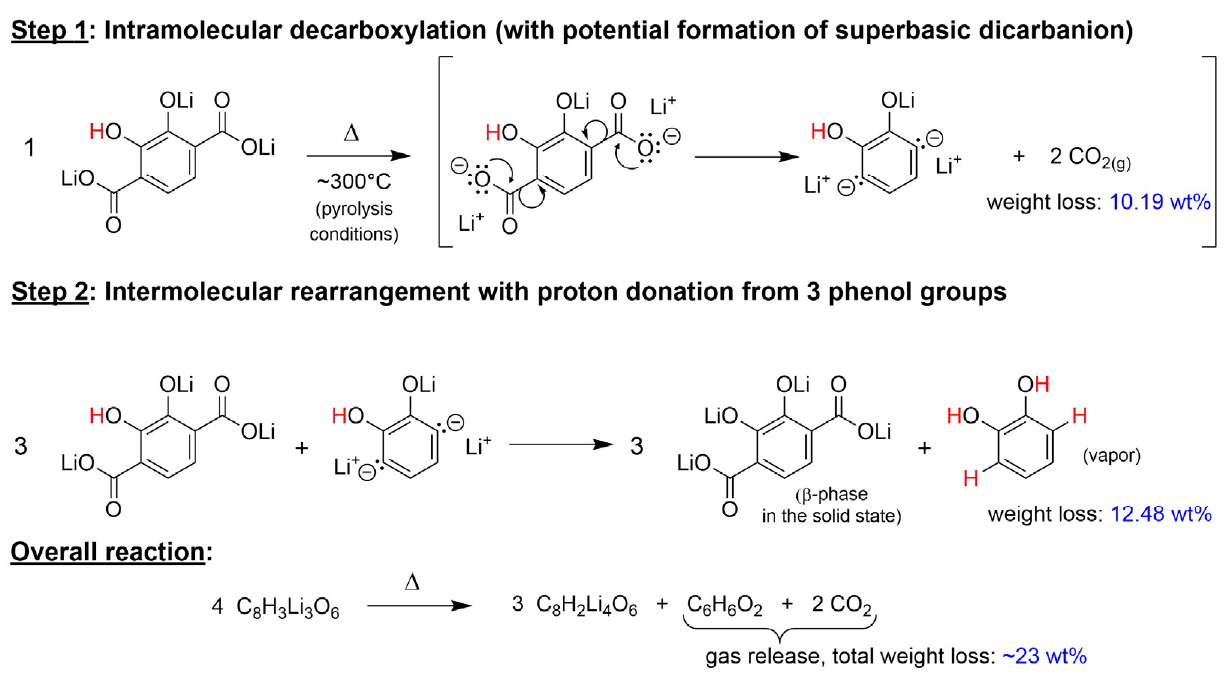
7 of 16 Figure 5. ( a ) Le Bail refinement of the PXRD of the Li 4 - o -DHT ( β -phase). The inset shows the good agreement between the experimental diffraction peaks and the Bragg positions at the low 2 θ angles. ( b ) Location of the o -DHT unit ( C 8 H 2 O 6 ) in the monoclinic lattice as obtained by the FOX software. Finally, the CO 2 evolution observed by TG-DSC-MS (Figure 2) was then quantified in a new series of dedicated experiments using micro gas chromatography. In practice, a few mg of (Li 2 )(Li,H)- o -DHT was placed in a glass ampoule, under argon atmosphere, and heated at 300 °C at 3.5 °C.min − 1 , which is a similar heating rate compared to both thermal analyses and TRXRPD measurements making the control of the pyrolysis reaction possi- ble. The weight loss of the sample due to CO 2 release in the gas phase was measured to be 10.9 ± 1.0%. Note that the use of much higher heating rates favors the thermal degradation